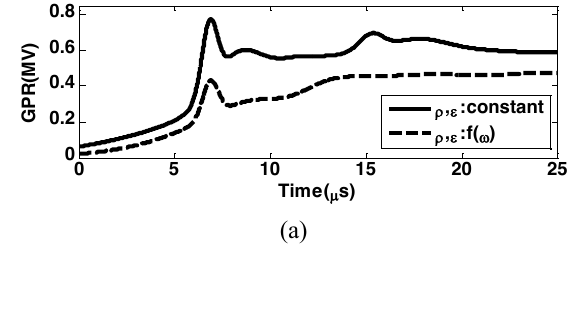
Figure 15: Transient voltage of grounding grid from the second example with two simultaneous injections at (a): port#1 and (b): port#2.